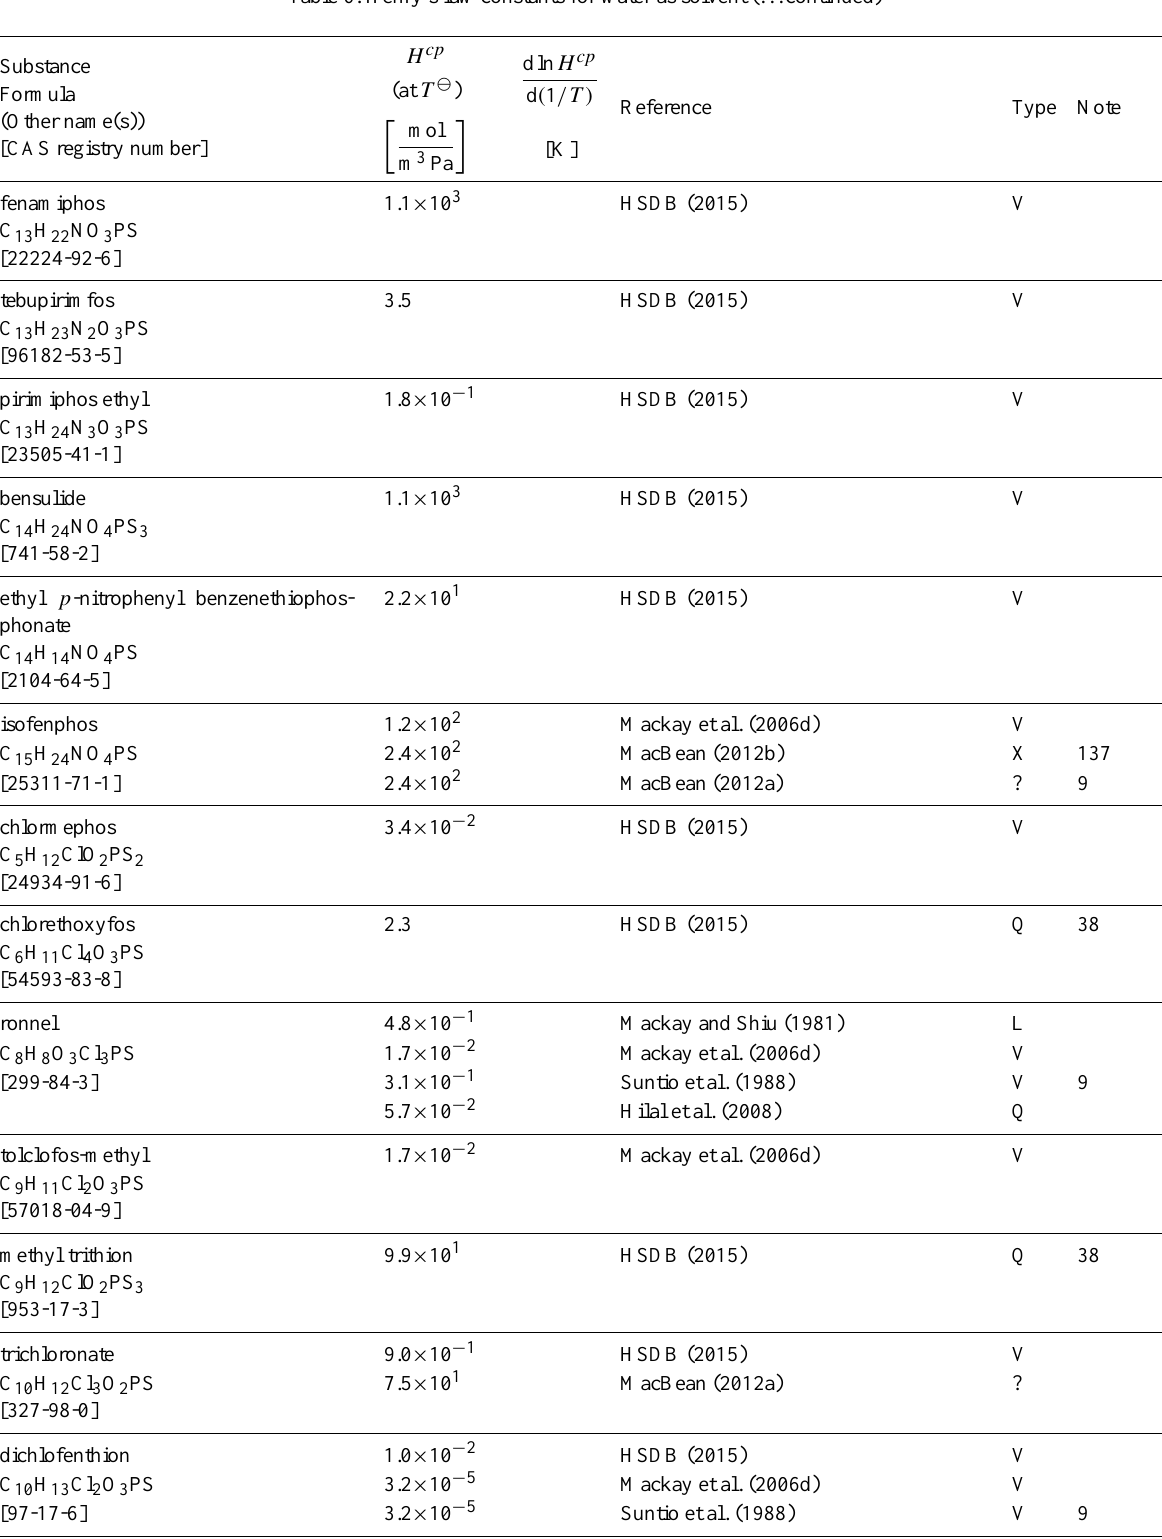
Table 6: Henry’s law constants for water as solvent